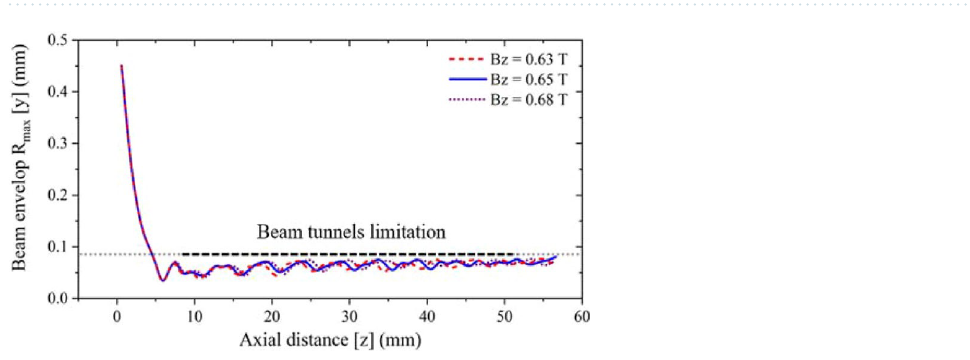
Figure 20. Beam envelope under the uniform magnetic focusing system with the axial magnetic field intensity fluctuation from 0.63 to 0.68 T.